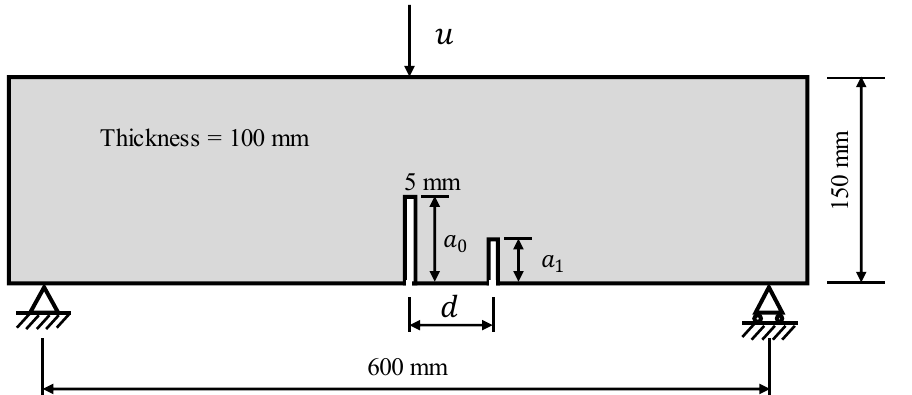
Figure 11. A concrete specimen: geometry, loading and boundary conditions.